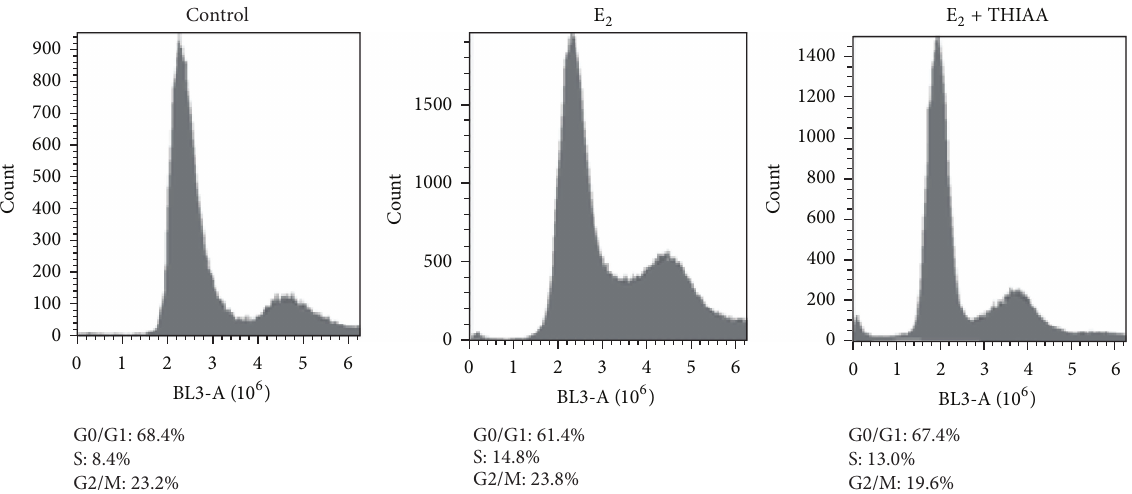
Figure 5: Effect of THIAA on E 2 -stimulated cell cycle progression in steroid-free culture medium. MCF-7 cells were grown during 72 h in the absence (control) or presence of E 2 at 10 −9 M with or without THIAA at 0.01%. Cell cycle phases were analyzed by flow cytometry after propidium iodine labeling. Data refer to a representative experiment performed independently three